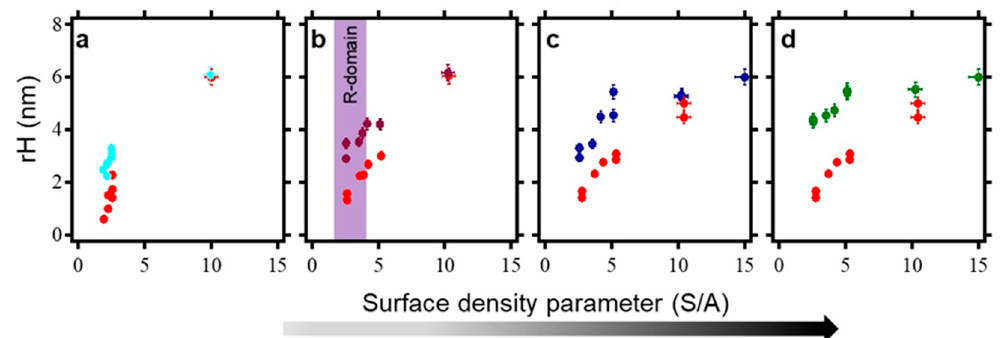
Figure 7. Dependency of hybridization on surface density of ssDNA nanopatch. ( a ) shows the plot of relative heights of density-dependent ssDNA nanopatches before (red) and after (cyan) treatment with 100 nM solution of complementary ssDNA–pep381 conjugate. ( b ) displays relative heights of density-dependent ssDNA nanopatches before (red) and after (plum) treated with a 200 nM solution of complementary ssDNA–pep381 conjugate. ( c ) shows the correlation between the initial relative heights of density-dependent ssDNA nanopatches (red) and the final relative heights (blue) of the same nanopatches after treated with 500 nM solution of complementary ssDNA–pep381 conjugate. Lastly, ( d ) displays the correlation of the initial relative heights (red) of density-dependent ssDNA nanopatches and the final relative heights (deep green) of the same nanopatches after treated with 1000 nM solution of the complementary ssDNA–pep381 conjugate. The R-domain is the optimum density domain at which we detect ß2m recognition. The dark bar shows the density gradient.